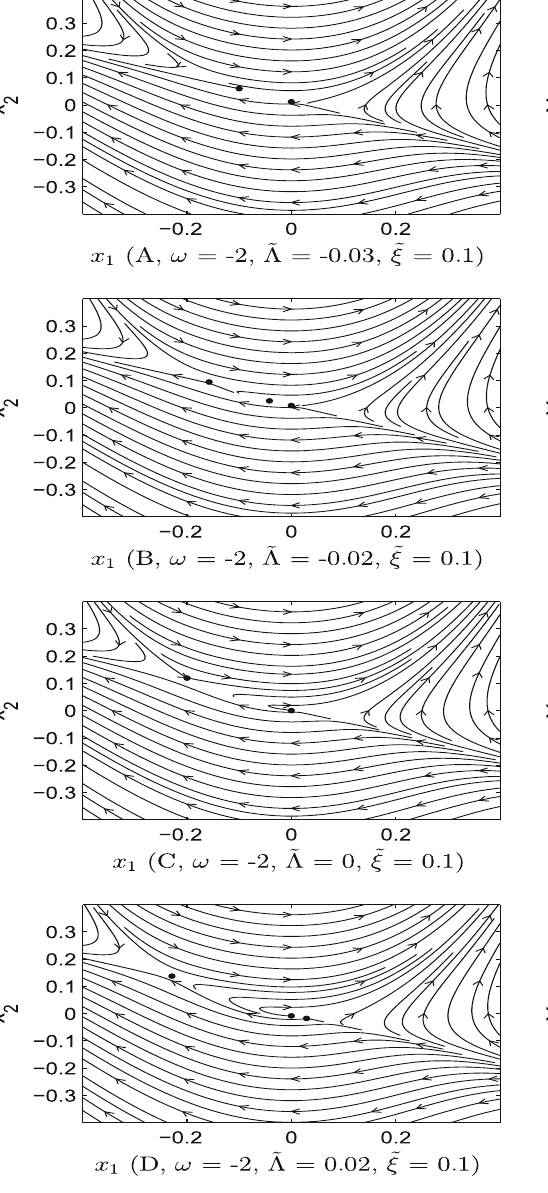
Fig. 18 Uncompact (left panel) and compact (right panel) phase less ˜ H and ˜ ρ as defined in Eq. (7). X and Y are the coordinates on portraits when viscosity is included, ˜ ξ = 0 . 1 for dust case the Poincaré sphere as defined in Eq. (47). The dotted circles represent (ω = − 2 ) but with different ˜ (cid:4) . Representative cases are ˜ (cid:4) = fixed {− 0 . 03 , − 0 . 02 , 0 , 0 . 02 } . x 1 and x 2 respectively denote the dimension-